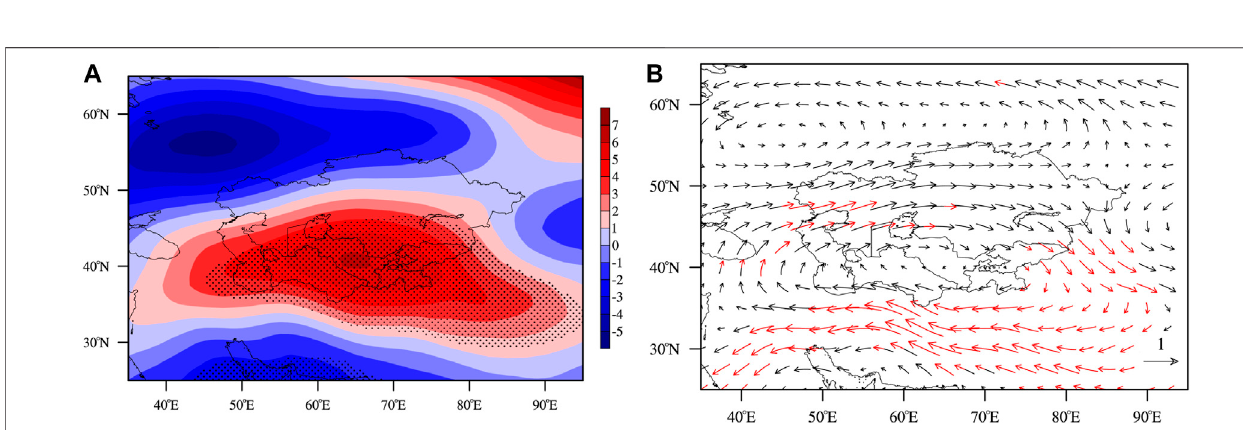
FIGURE 11 | (A,B) show the regression coef fi cients of MUTTI for geopotential height and wind fi eld at 500 hPa, respectively. The dotted area in (A) and the red wind fi eld in (B) show the area that passed the 90% con fi dence level student ’ s t-test.